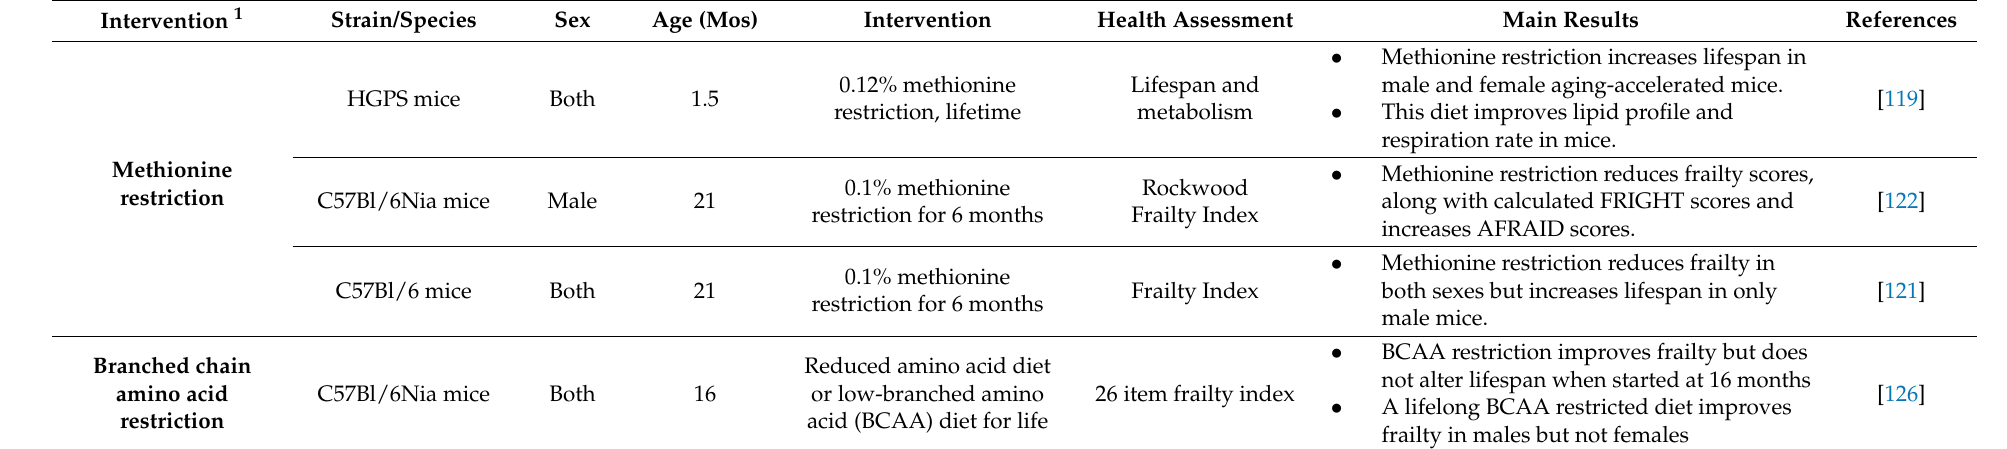
Table 3. Amino acid restriction interventions to enhance overall health and reduce